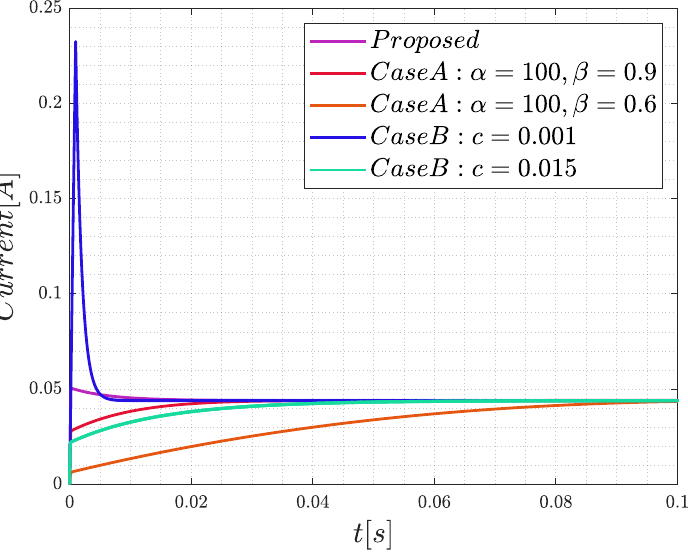
Figure 5. Current responses of the SMC for the three sliding surfaces described in Section